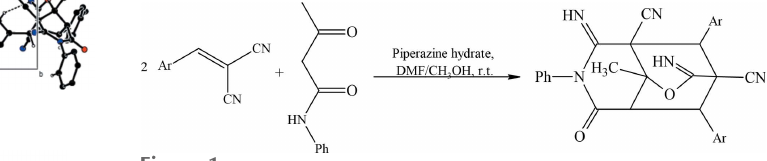
Figure 1 Chemical scheme for the one-pot synthesis of tricyclic pyrano[3,2- c ]- pyridine